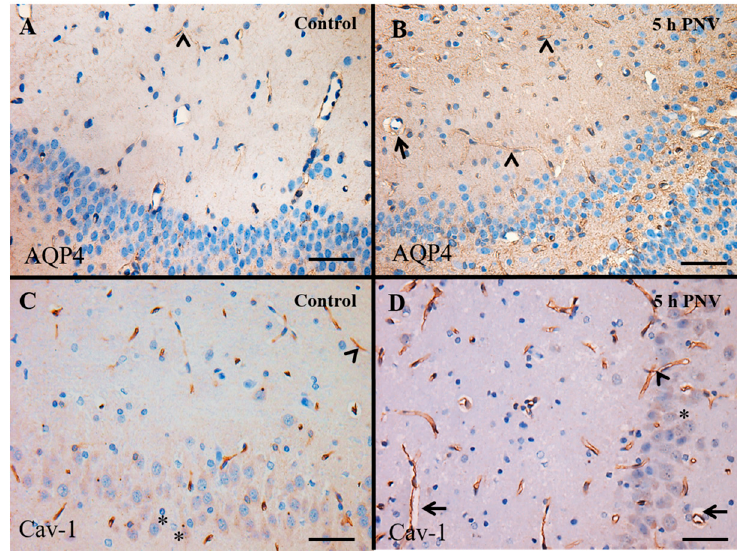
Figure 2. Illustrative immunohistochemical localization of aquaporin (AQP4) and caveolin-1 (Cav-1) in an adult animal administered saline ( A , C ) or Phoneutria nigriventer venom (PNV) ( B , D ) in CA3. ( A , C ) The AQP4 and Cav-1 physiologic expression in controls; and ( B , D ) PNV-induced up-regulated AQP4 and Cav-1, respectively. Arrowhead: vessel labeling. Arrow: perivascular edema formation in hippocampus capillaries of PNV-administered animals. Asterisk: neuronal labeling. Scale Bar: 100 µm